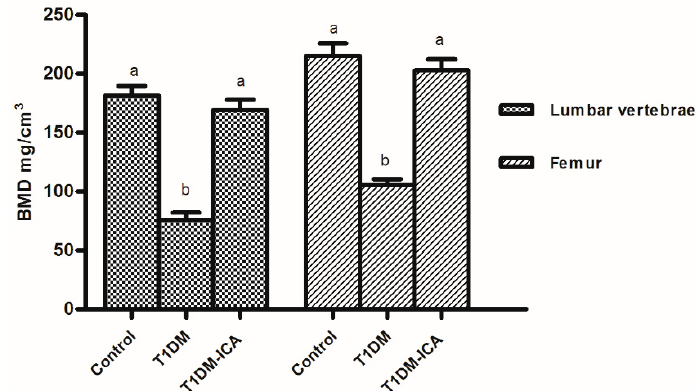
Figure 2. The lumbar vertebrae and femur bone mineral density (BMD) of rats in each group. Values are presented as means ± SD. Different letters were used to indicate statistically significance difference ( p < 0.05).